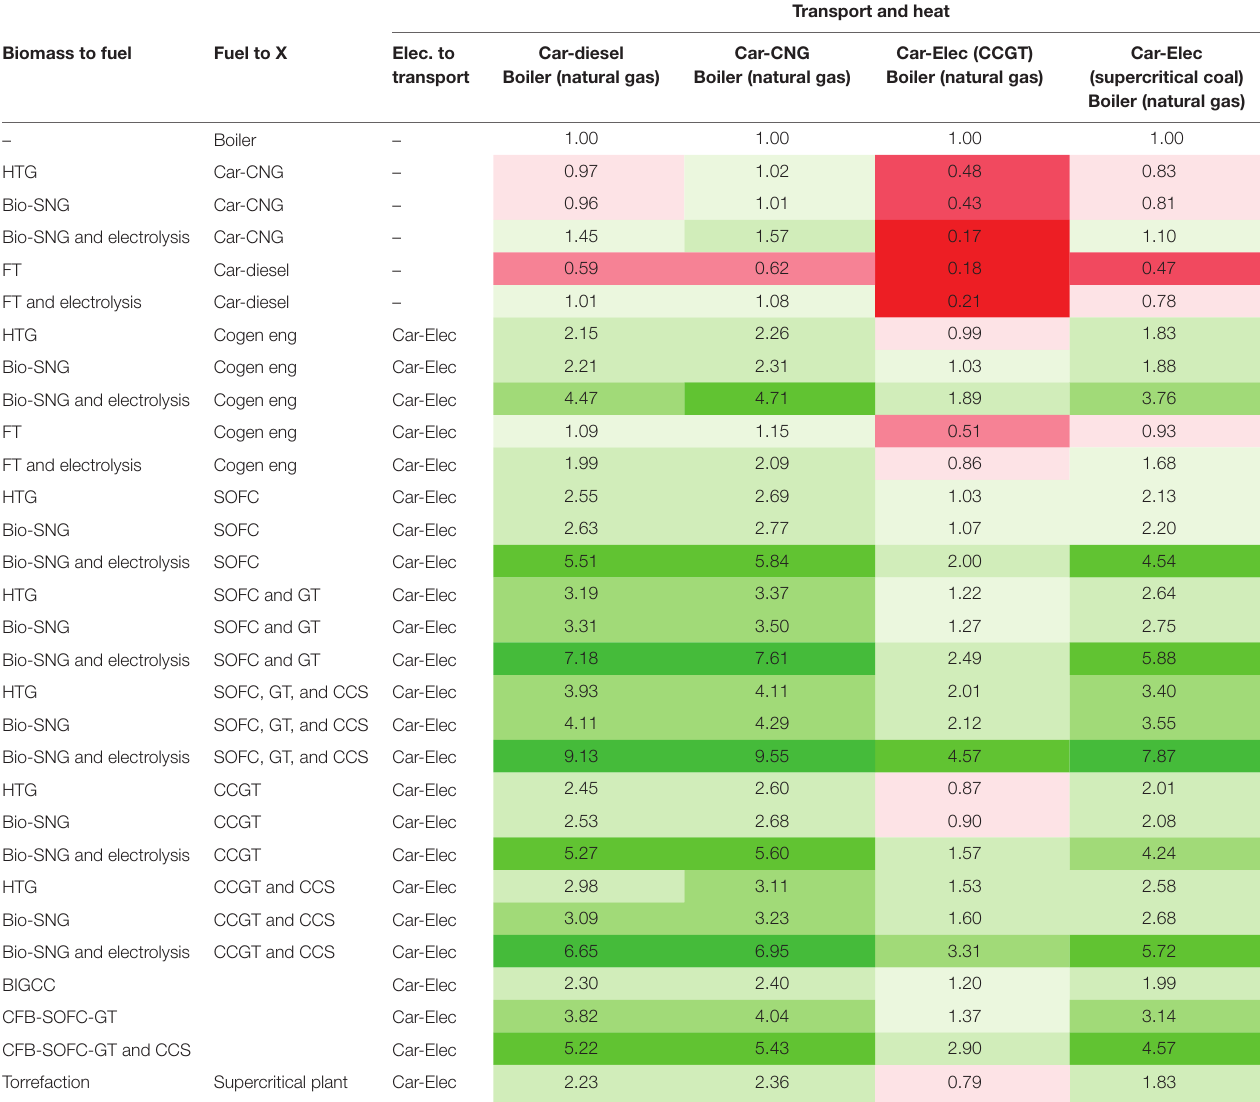
TaBle 6 | Fossil CO 2 emissions reduction through the substitution of natural gas by biomass usage pathways for space heating and mobility (reference value: 1 00 . ≡ 0.211kg 2